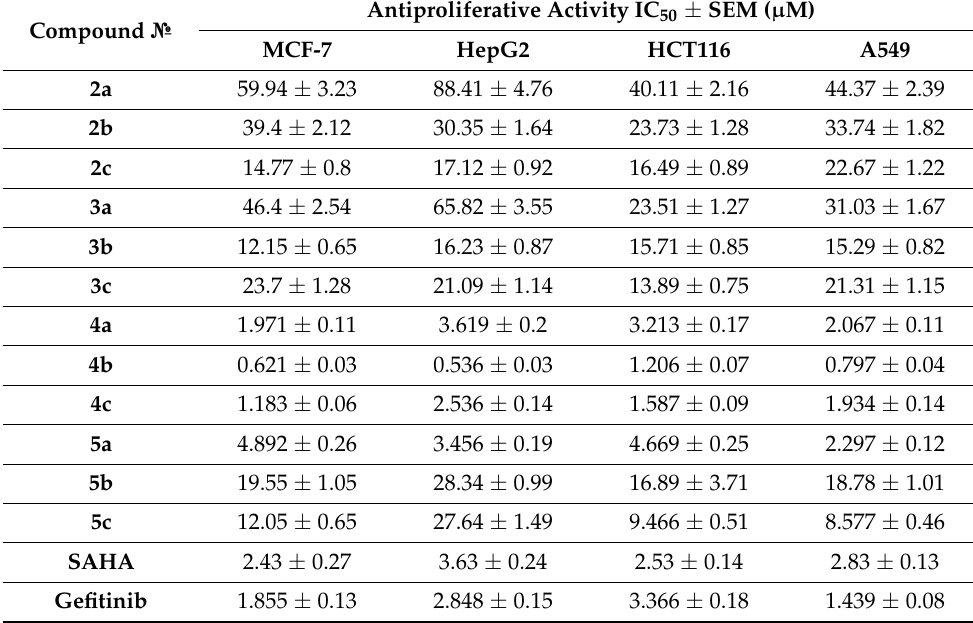
Table 1. Antiproliferative activity of the hybrids 2a – c, 3a – c, 4a – c and 5a – c . Compound